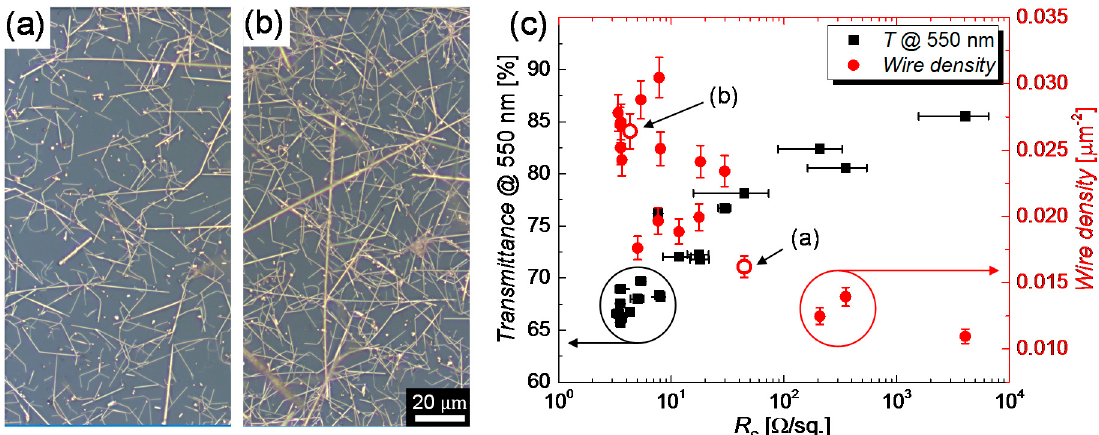
Figure 7. Light microscope images for CuNW films with ( a ) a low and ( b ) a high wire density. ( c ) Transmittance evaluated at a wavelength of 550 nm and wire density as a function of the room temperature resistance. The wire densities corresponding to the images ( a , b ) are indicated by red hollow symbols.